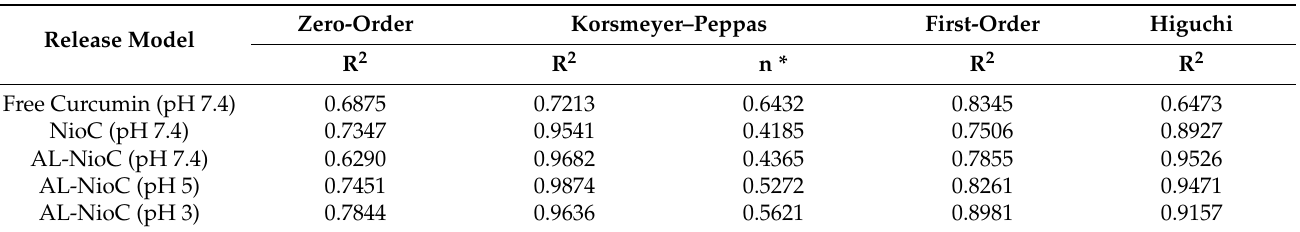
Table 9. The dynamic release models and the factors gained for niosomal formulation in optimum condition.